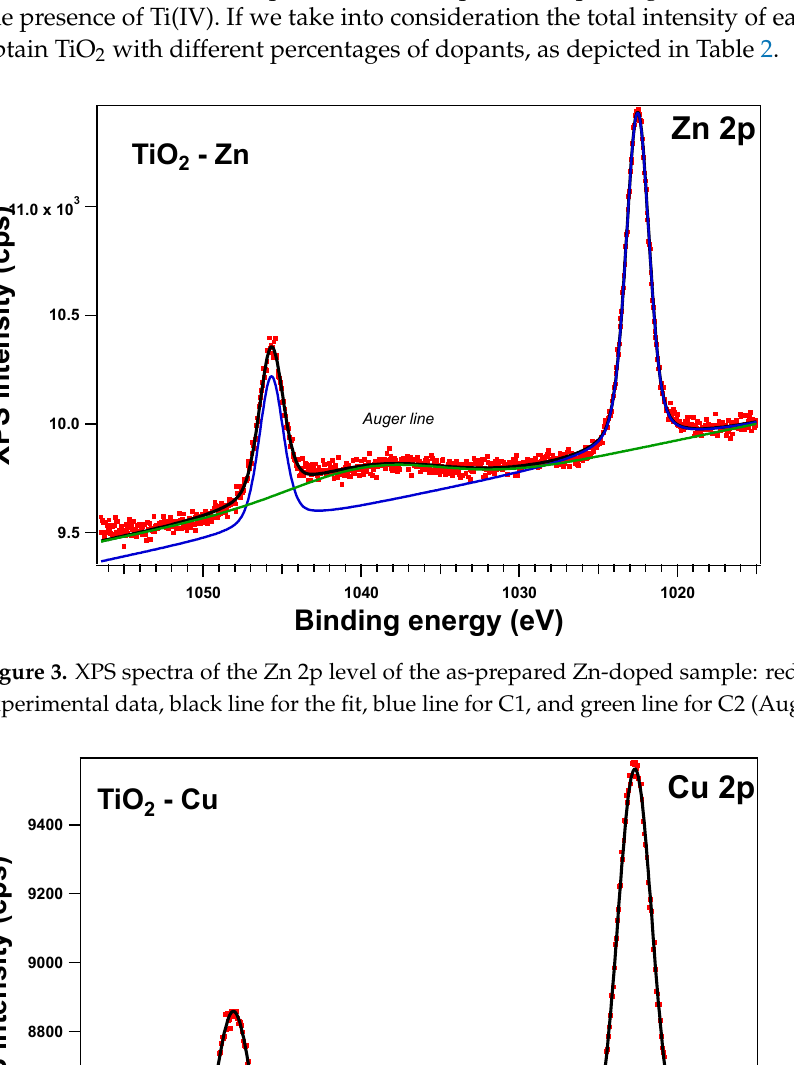
( c ) Figure 5. XPS spectra of the Ti 2p level: ( a ) comparison between the experimental data: red line for Zn-doped samples and blue line for the Cu-doped samples, and ( b , c ) the fi t and deconvolutions for the Zn sample and Cu sample, respectively: red symbols for the experimental data overlayed with a black line for the fi t, blue line for C1, and green line for C2.